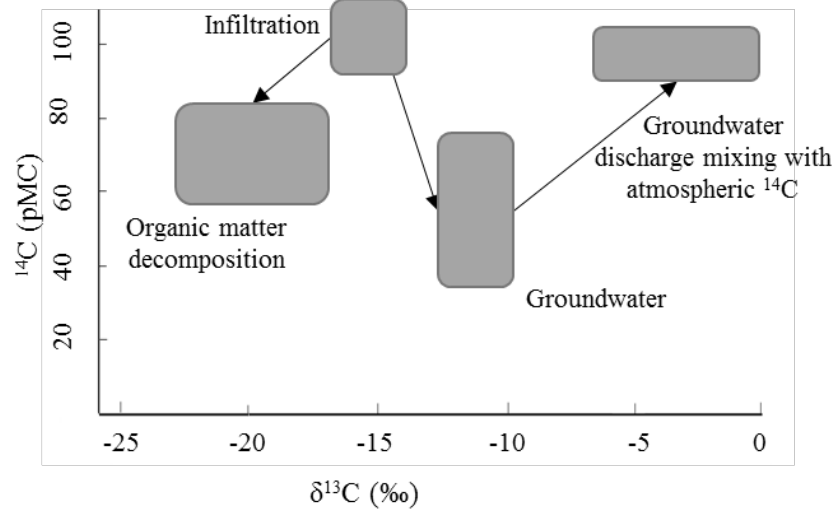
Figure 10. The 14 C/δ 13 C relationships with the possible origins and mixtures of groundwater from infiltration to discharge (adapted from Mook